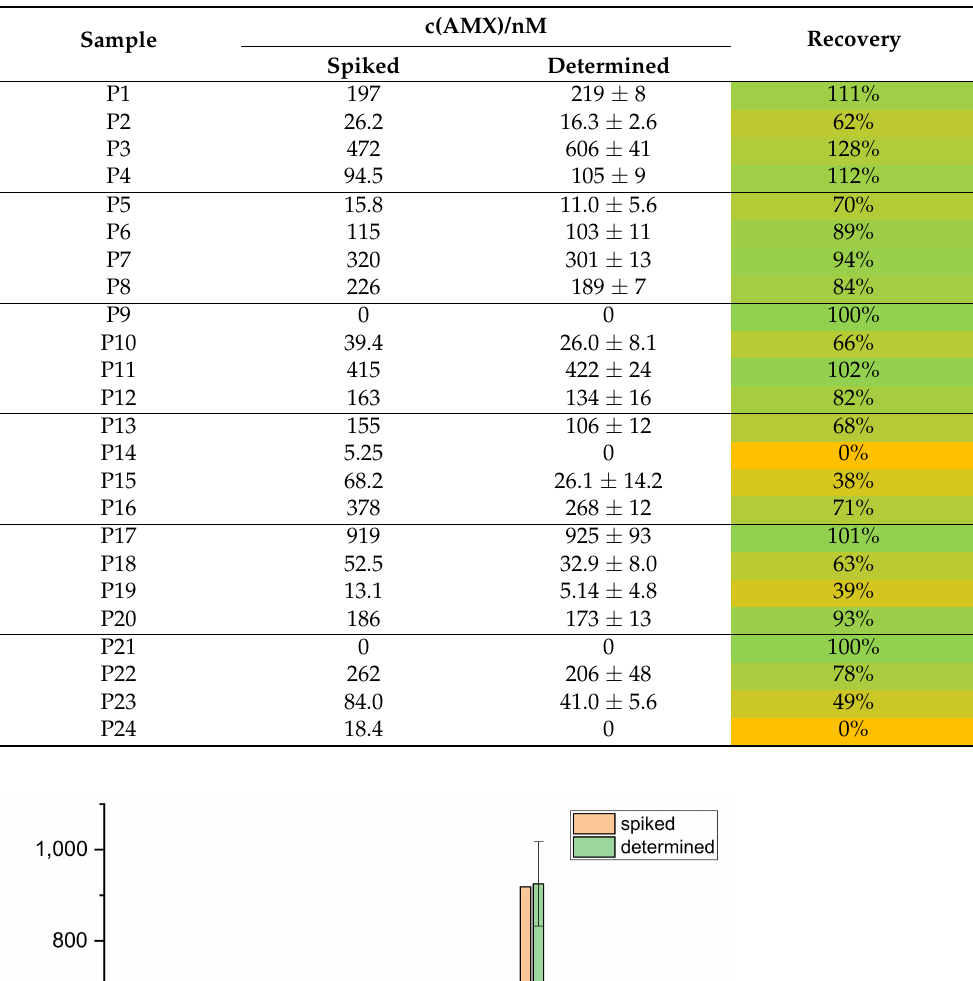
Table 1. Results of AMX determination in spiked water samples by ELISA.